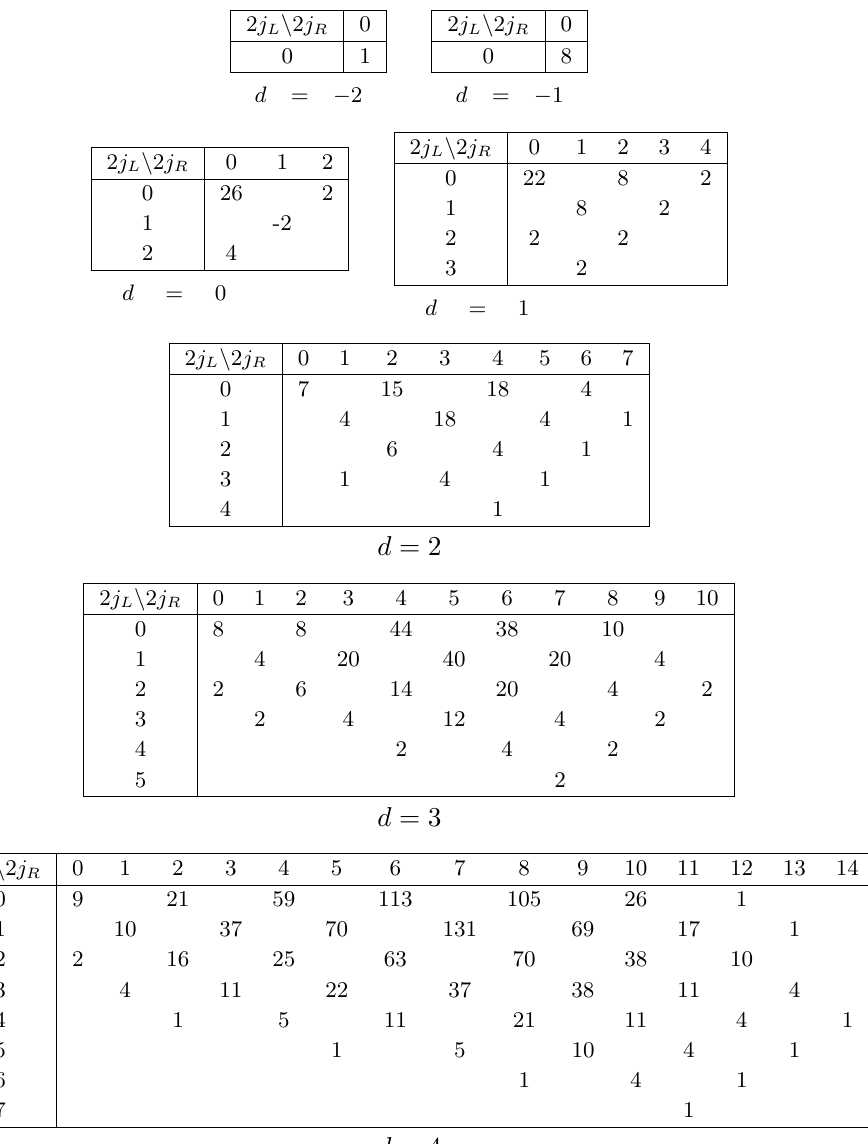
Table 13 . Pseudo-BPS spectrum of Wilson loop for local P 1 × P 1 in the representation 2 ⊗ 4 of SU(2) for the curve class dt = 2 dφ